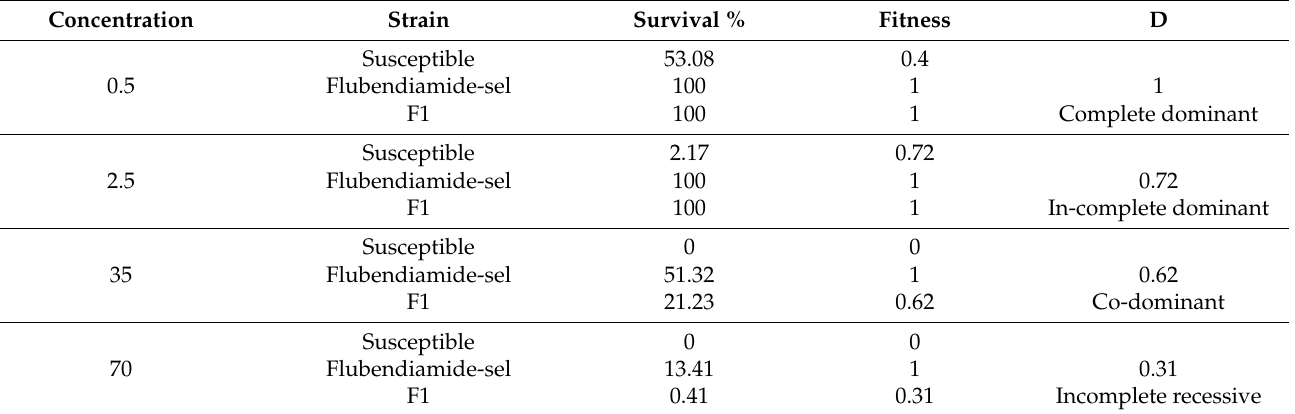
Table 7. Dose dependent effective dominance of flubendiamide-sel population of Tuta absoluta .